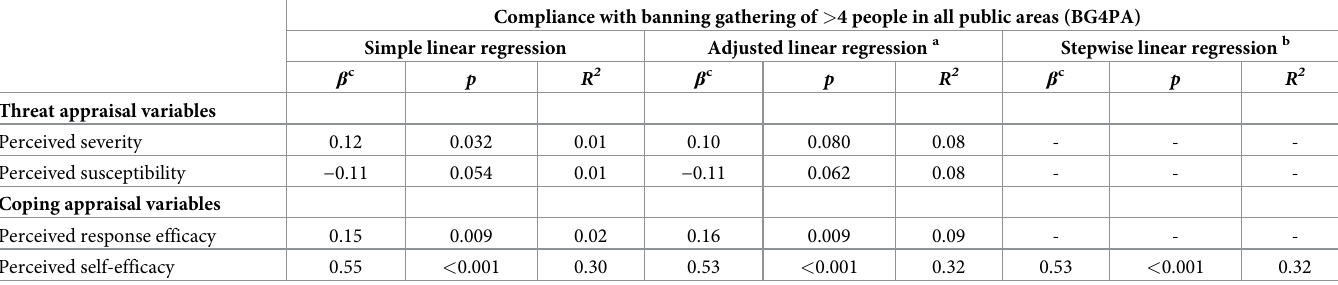
Table 4. Associations between the constructs of the Protection Motivation Theory (PMT) and compliance with BG4PA (n = 300). Compliance with banning gathering of > 4 people in all public areas